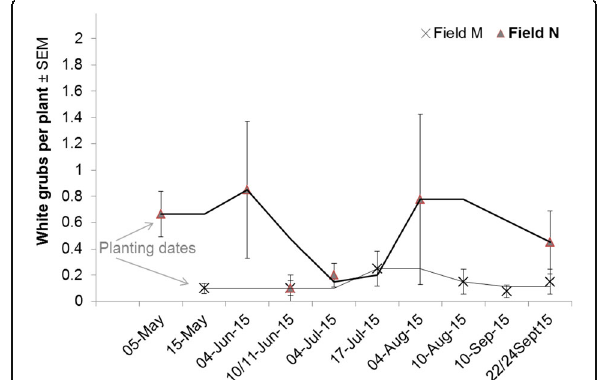
Fig. 3 Population dynamics of Anomala and Hoplochelus white grubs in Irish potato fields during experimental periods in field M in Musanze and field N in Nyamagabe in Rwanda in 2015. Assessed from the soil at 0 to 15 cm below and around 10 plants in 4 untreated control plots in each field per date. Error bars = SD. Trendline= moving